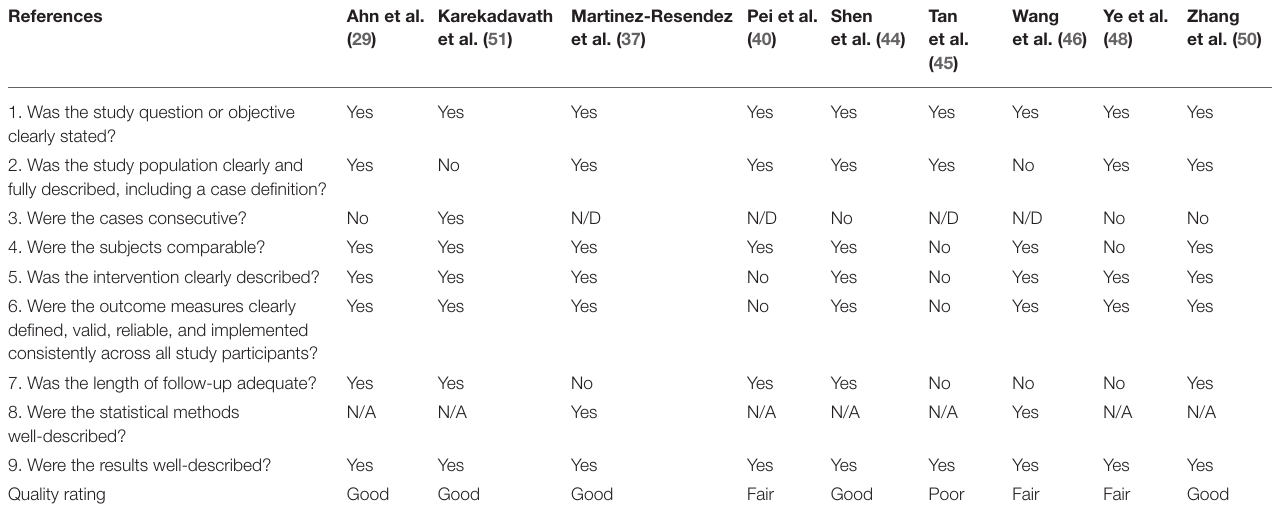
TABLE 2E | Quality assessment of the case studies included in the